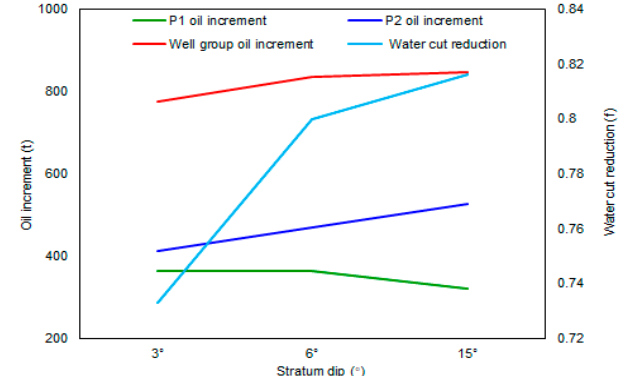
Figure 5. Oil increment and water-cut reduction under different stratum dips.